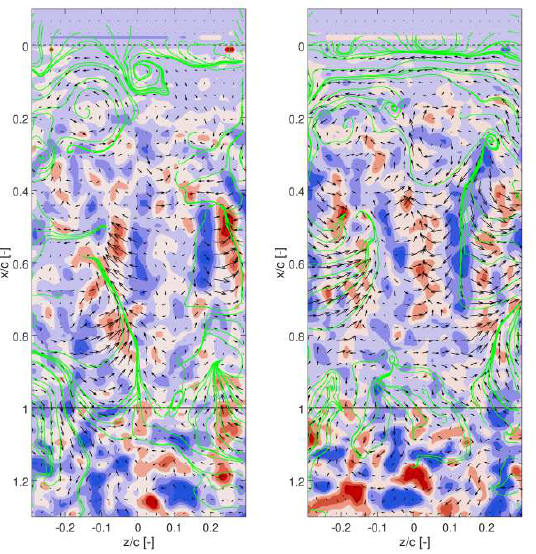
Fig. 8. Spanwise slices of plane y w /c = 0.01 m . Velocity POD modes no. 1 (left) & 2 (right). Content 3.1% & 2.8% of TKE.